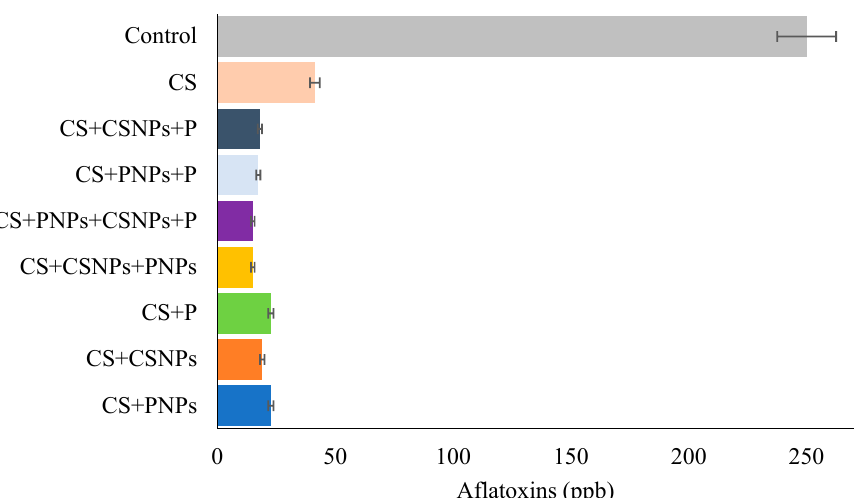
Table 5. Sensory characteristics of fig fruit treated with different nanostructured coatings.